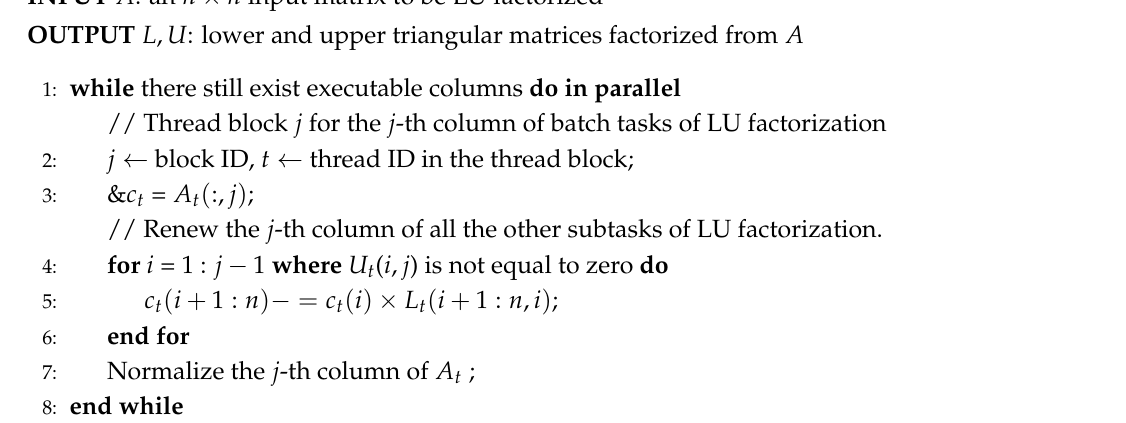
Algorithm 2 GPU-based batch LU factorization